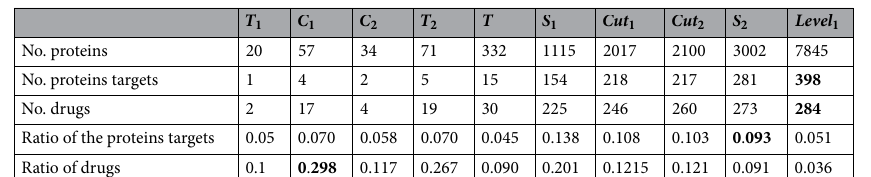
Table 4. The summary of drug targets and related drugs for Clinical-Drug group. The first row shows the size of T 1 , C 1 , C 2 , T 2 , T , S 1 , Cut 1 , Cut 2 , S 2 , Level 1 sets. The number proteins targets and related drugs in each set for Clinical-Drug group are reported in second and third rows, respectively. The fourth and fifth rows show the ratio of the number of proteins that targeted and their related drugs in each set for Clinical-Drug group to the size of sets, respectively. The complete description of sets is presented in Table